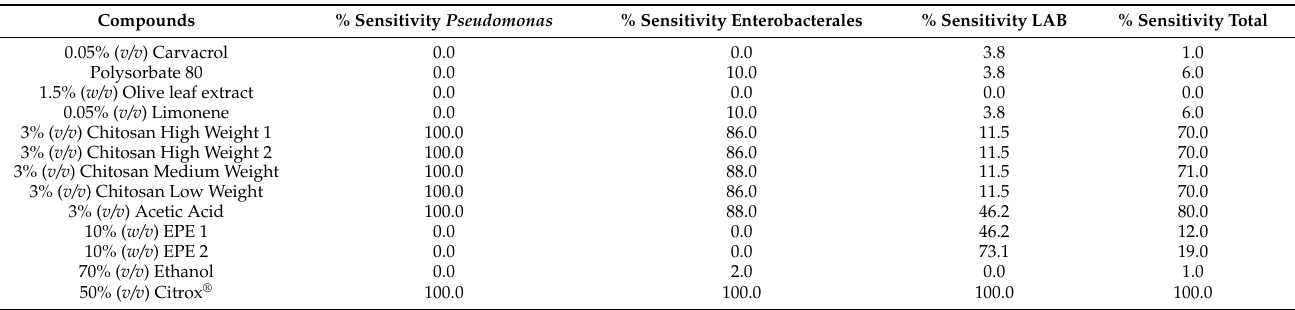
Table 5. Screening of antimicrobial activity of 10 natural compounds and respective controls.